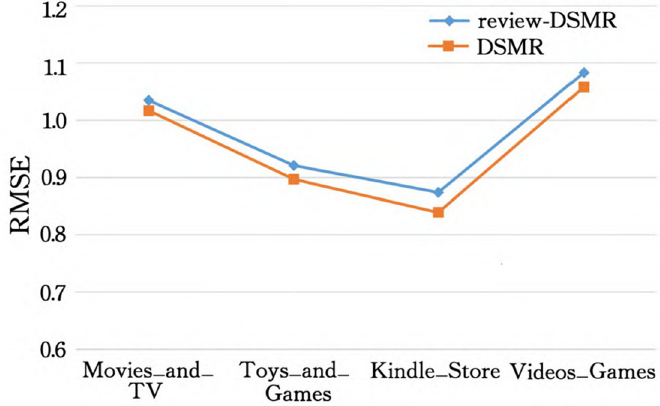
Fig 6. Comparison of roc and precision-recall between review-DSMR and